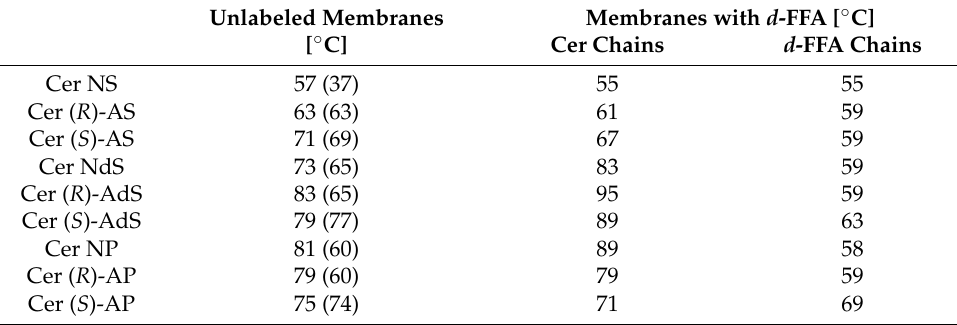
Table 2. Main phase transition temperatures deduced from methylene symmetric stretching in Cer/( d )-FFAs/Chol/CholS membranes containing either sphingosine (Cer NS, Cer ( R )-AS, or Cer ( S )- AS), or dihydrosphingosine (Cer NdS, Cer ( R )-AdS, or Cer ( S )-AdS) or phytosphingosine Cers (Cer NP, Cer ( R )-AP, or Cer ( S )-AP) at ambient room humidity. The numbers in brackets indicate doublet disappearance (deduced from methylene scissoring vibration), which indicates an orthorhombic– hexagonal transition. Unlabeled Membranes Membranes with d -FFA [ ◦ C] [ ◦ C] Cer Chains d -FFA